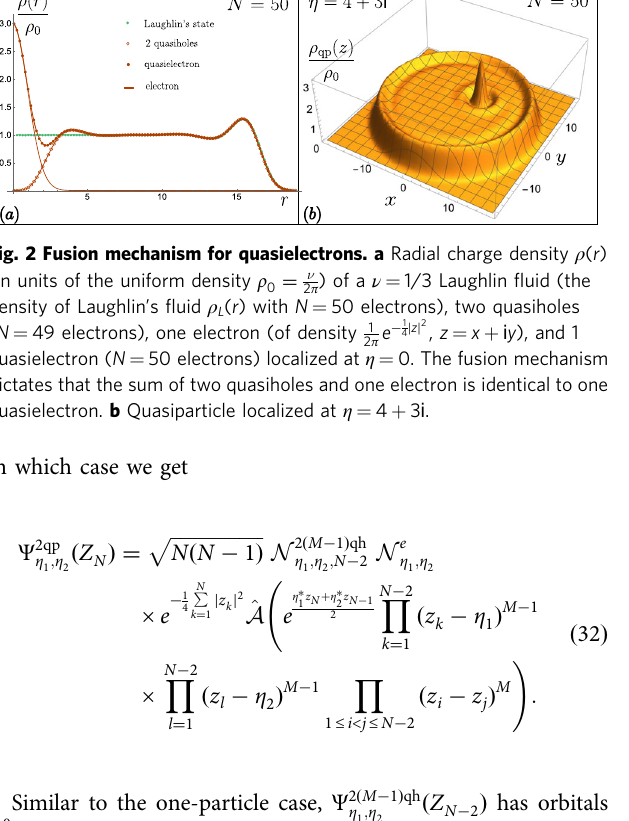
Fig. 1 Quasiparticles and quasiholes for Laughlin fl uids. a , b represent density pro fi les (in units of the uniform density ρ located at position η of an incompressible ν = 1/3 Laughlin fl uid with N = 7 particles. c depicts two quasiholes in an otherwise ν = 1/3 Laughlin fl uid with N = 6 particles (adding the electron charge density 1 e (cid:4) 1 4 j z (cid:4) η j 2 (with z = x + i y ) leads to the exact same b ). d – f are contour plots of their 3D plots from 2 π a – c , respectively. Monte Carlo simulations are averaged over more than 2 × 10 10 equilibrated con fi gurations.